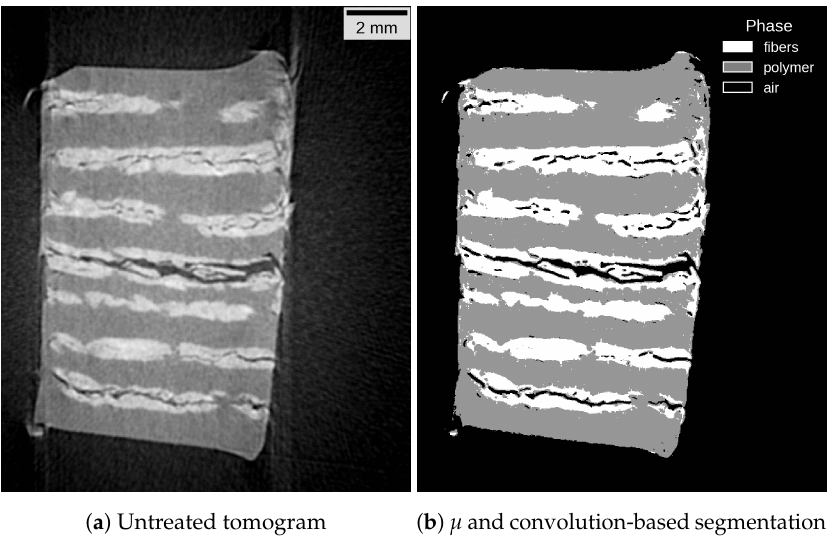
Figure 2. X-ray tomogram ( a ) untreated; ( b ) after µ and convolution-based